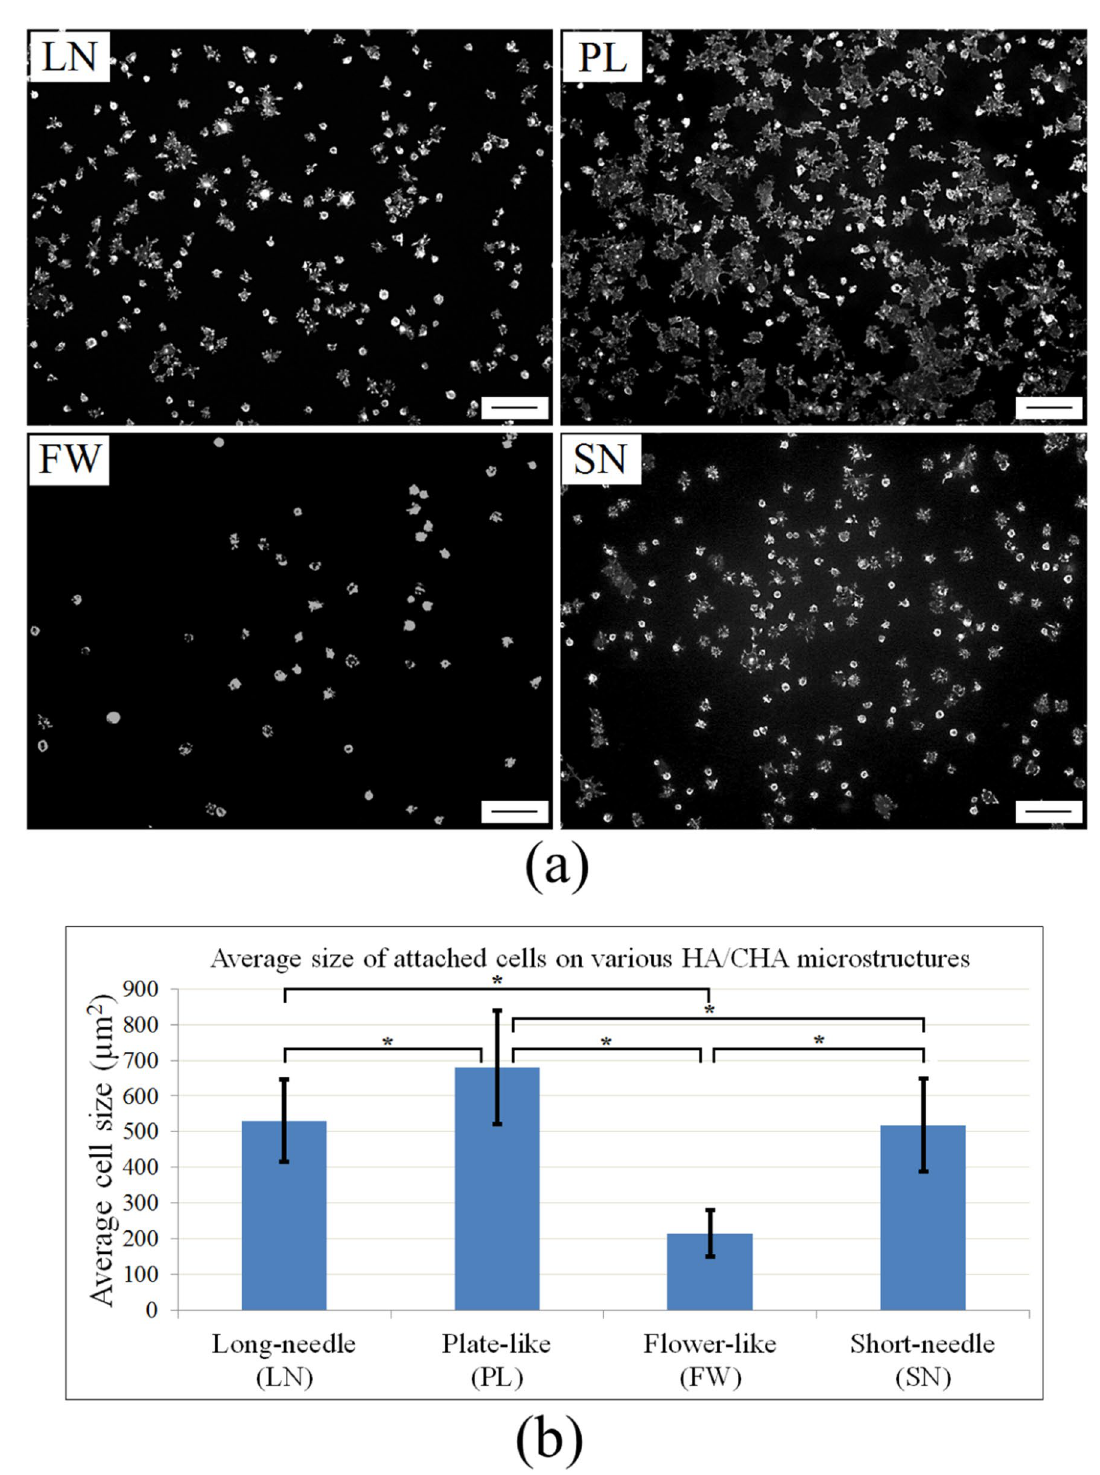
Figure 3. Size of cells attached to bioactive glass monoliths with different nanopore size and HA/CHA microstructure. The actin cytoskeleton of MC3T3-E1 cells attached after 2 h to monoliths was stained with Alexa488-conjugated phalloidin and imaged by fluorescence microscopy. ( a ) Representative black and white images of the actin cytoskeleton of cells attached on long-needle (LN), plate-like (PL), flower-like (FW), and short-needle (SN) HA/CHA-covered monoliths (scale bar = 100 µm). ( b ) Quantitative analyses of the average size of attached cells on the HA/CHA layer determined by measuring the stained area covered by cells in multiple images of three independent experiments. Significant differences in cell numbers are marked with